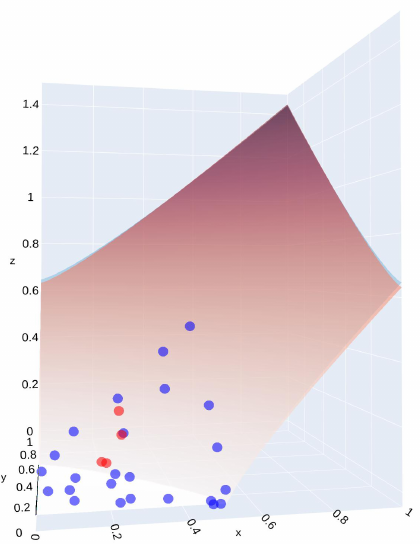
Figure 8. Parameter estimation with the use of an evolutionary algorithm for the conjunctive case. The blue points represent the samples with λ = 1.25, whereas the red points are the ones that were created with λ = 0.75 or λ = 1. The blue surface is the one created by the application of the function (10) with the original λ = 1.25. The red surface is the one created by the application of the same function with the best found λ =